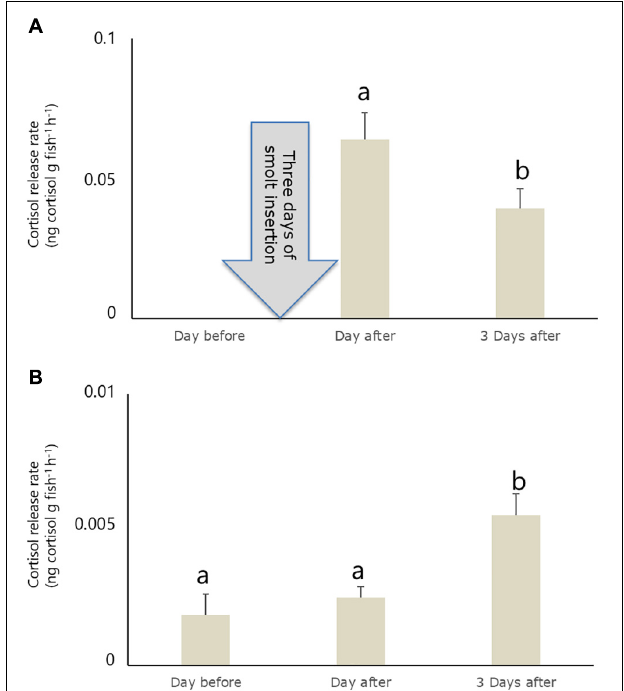
FIGURE 2 | Cortisol release rate in raceway 1 (A) and raceway 2 (B) before and after a 4 days smolt insertion period in raceway 1. Raceway 1 was emptied before smolt insertion. Different lowercase letters indicate a significant difference ( p < 0.05) between sampling occasions within a raceway. Values are averages of three samples ±